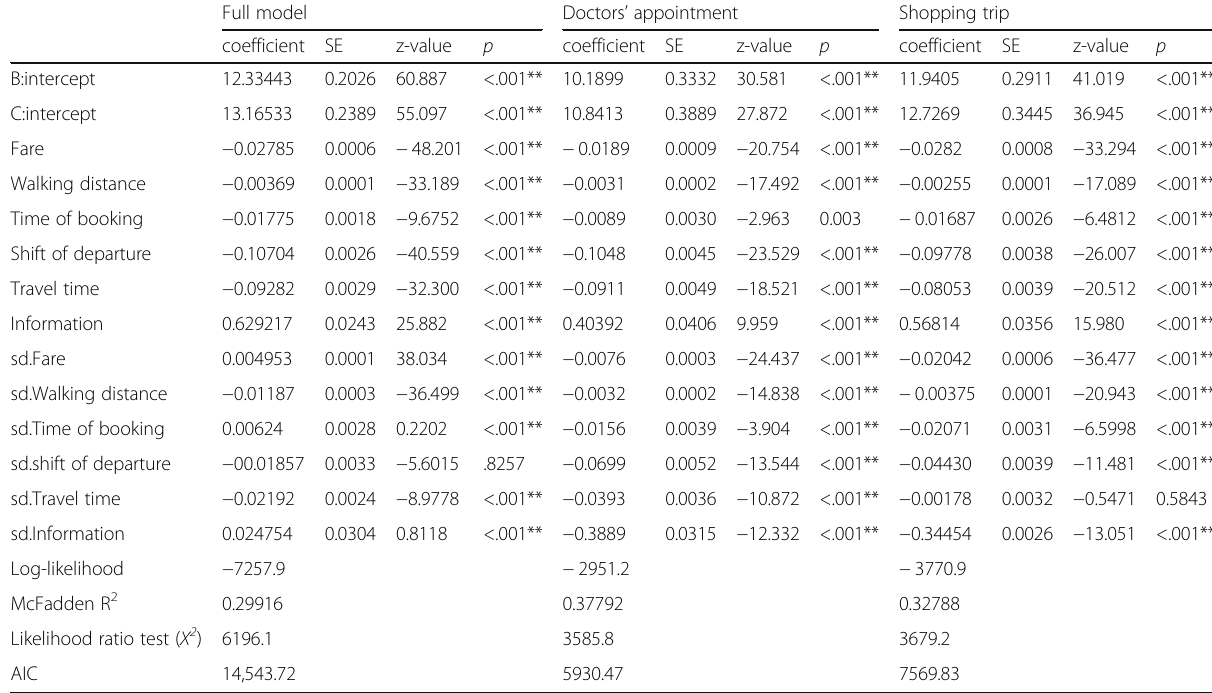
Table 4 Results of mixed multinominal logistic